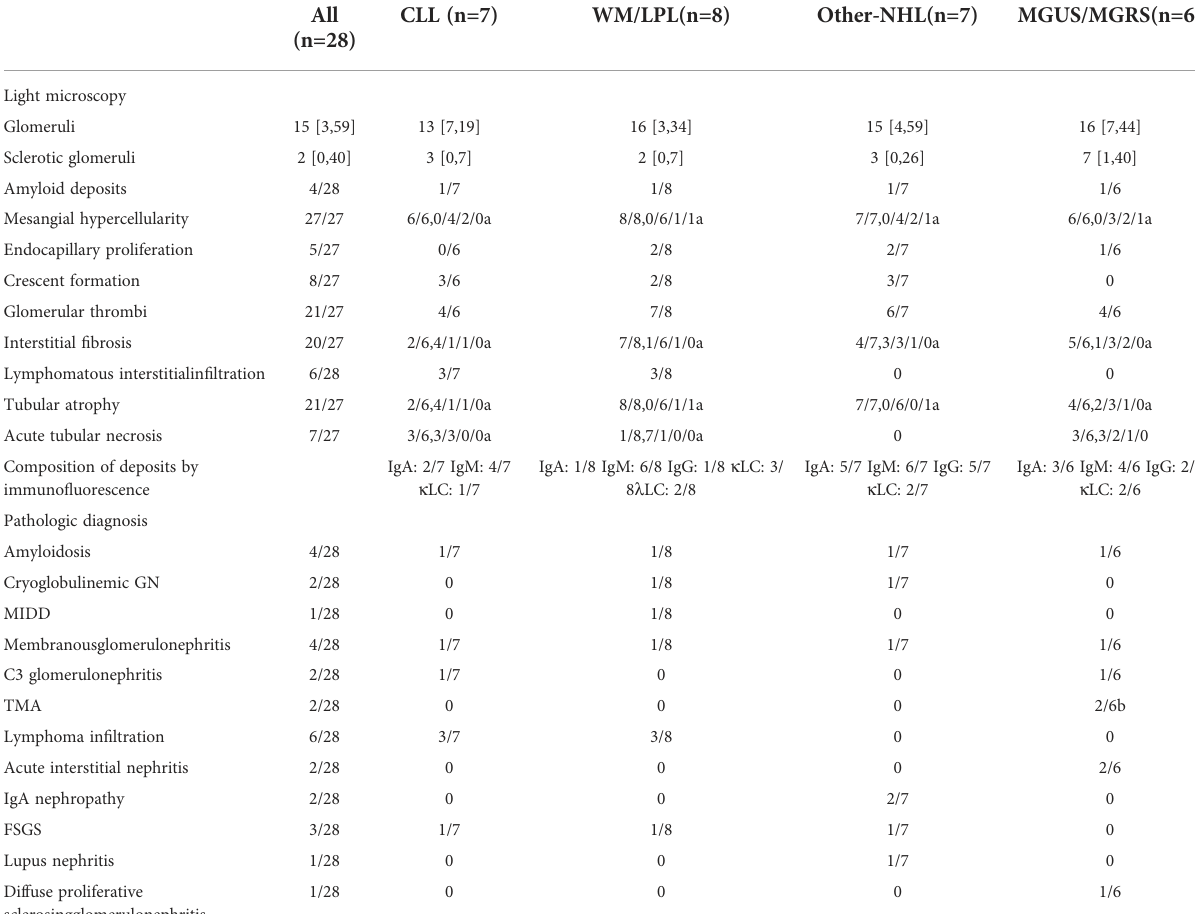
TABLE 2 Renal biopsy fi